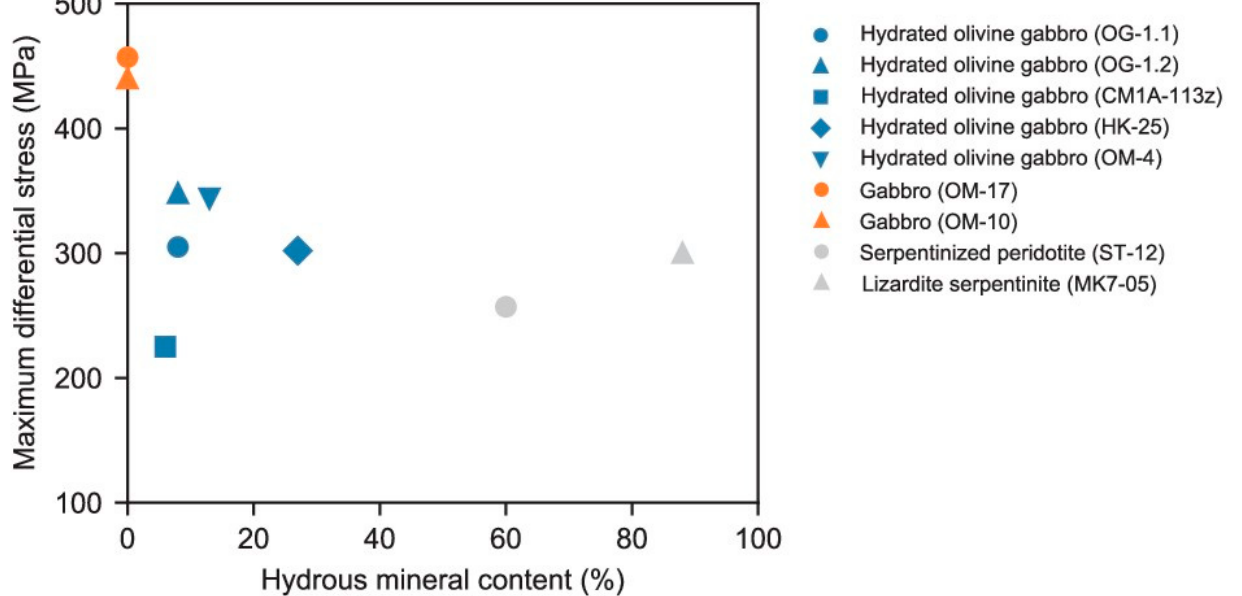
Figure 4. Relationship between the maximum differential stress and the hydrous mineral content of each sample.